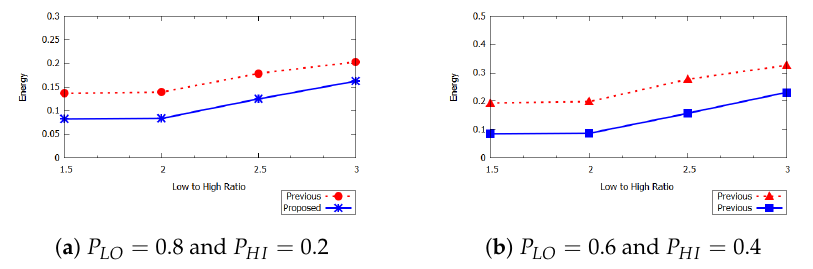
Figure 8. The impact of ratio r .